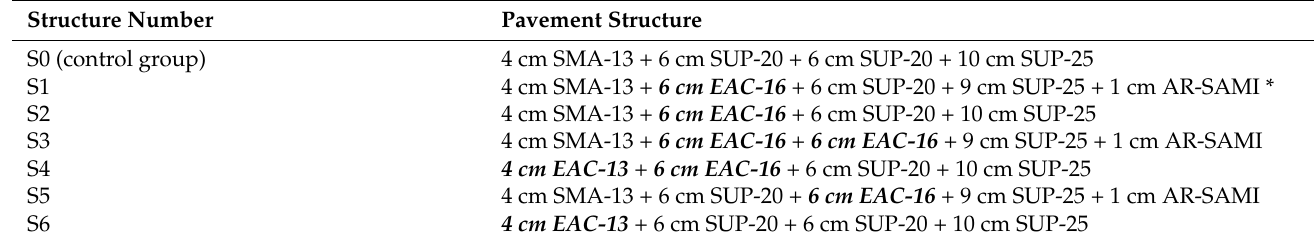
Table 4. Summary of 7 pavement